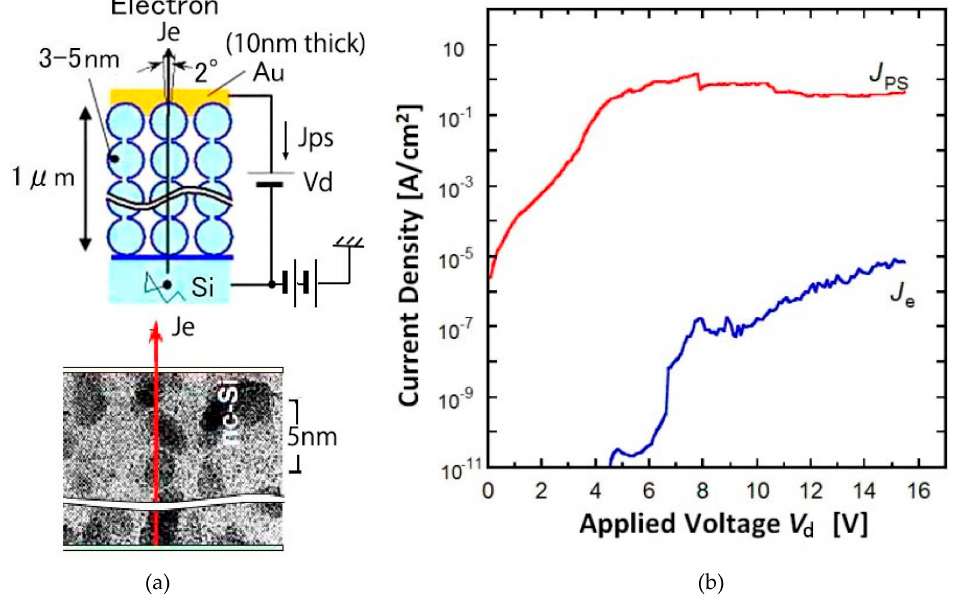
Figure 13. nc-Si electron emitter; ( a ) principle; and ( b ) characteristics.